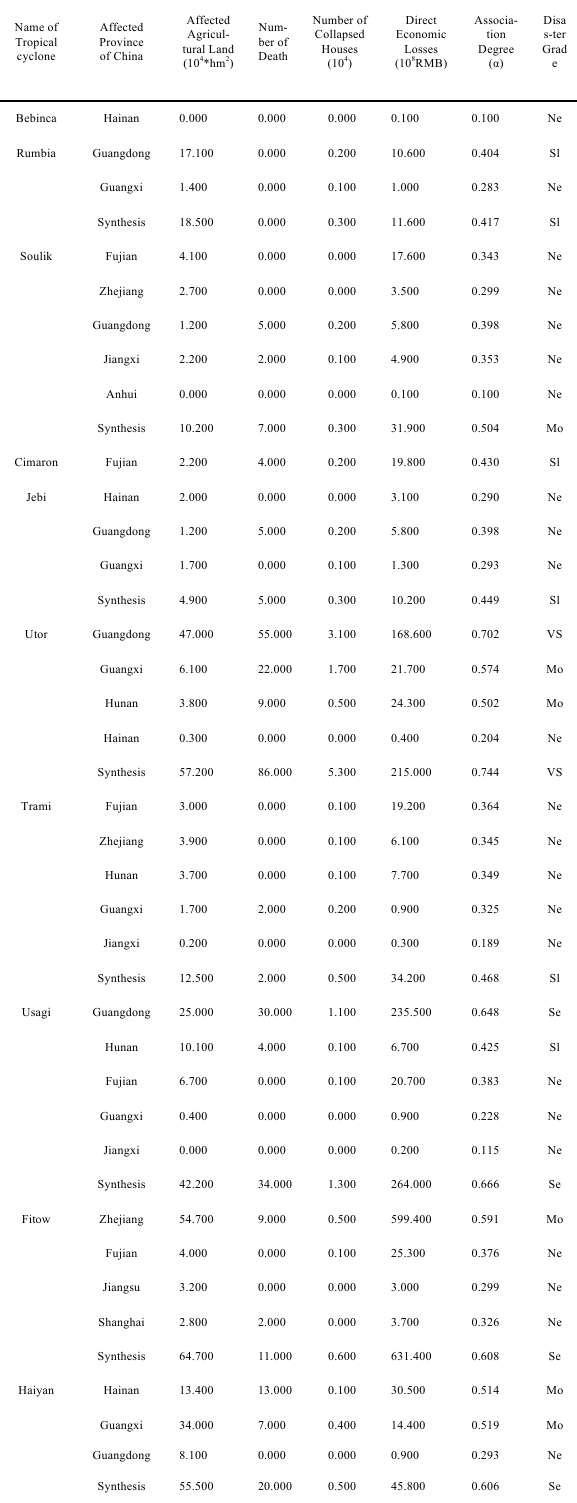
grading 2.3. Raw Weibo Data and Filtering The row data set for tropical cyclones in 2013 was collected through Weibo Application Programming Interface (API).